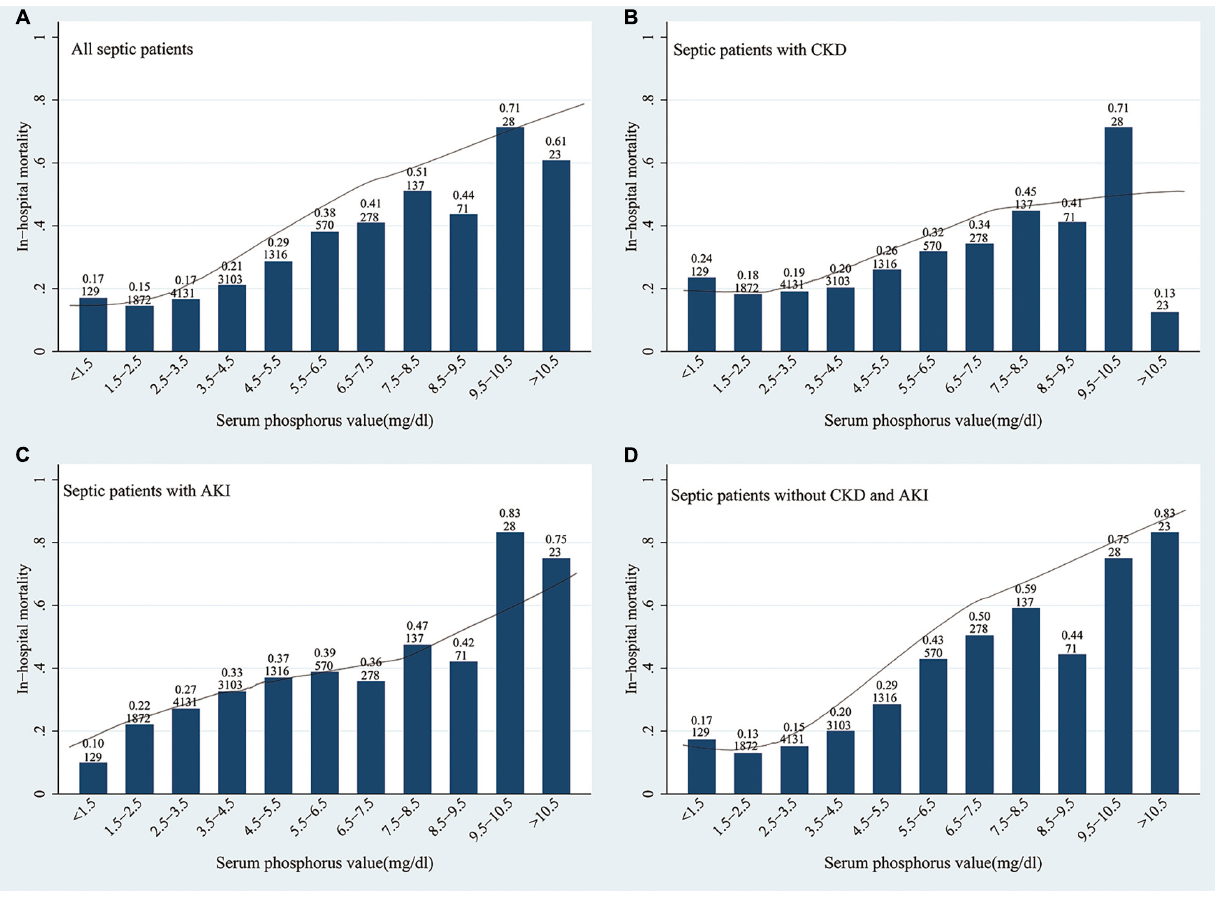
Frontiers in Medicine |